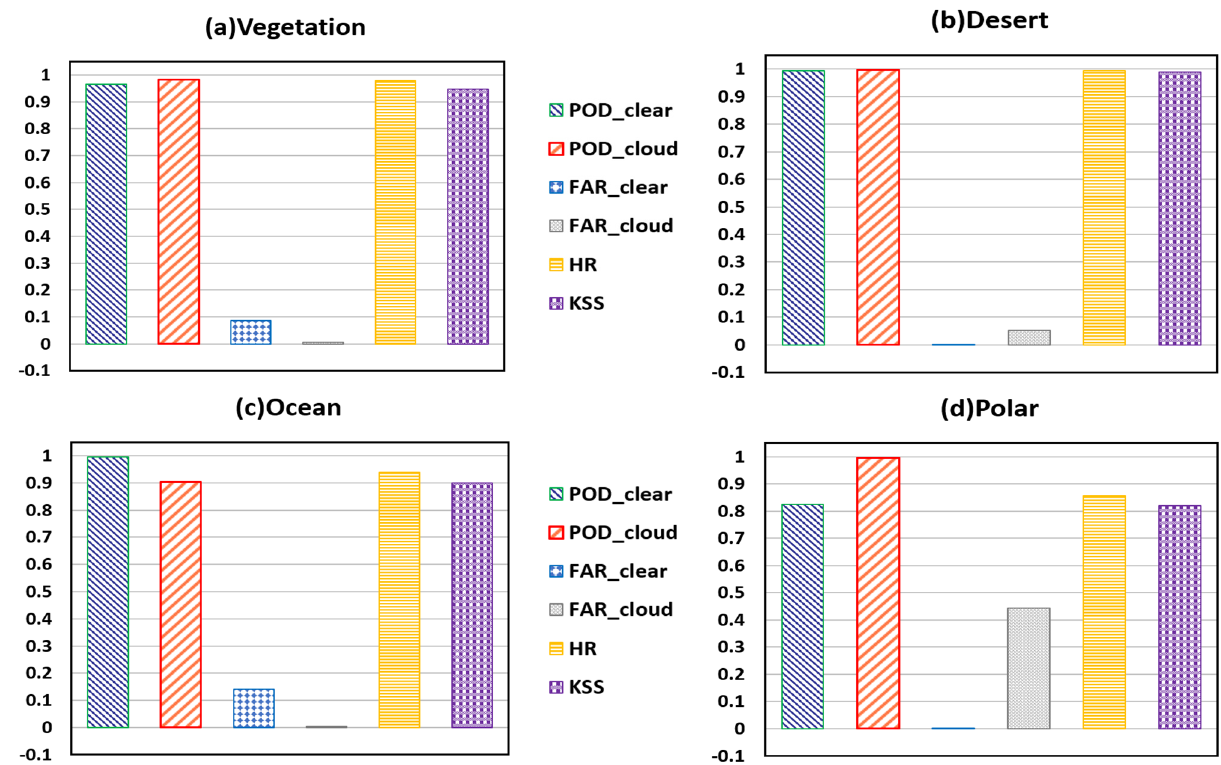
Figure 11. POD, FAR, HR, and KSS scores of NNDT algorithm in four scenes: ( a ) vegetation ( b ) desert ( c ) ocean, and ( d ) polar.